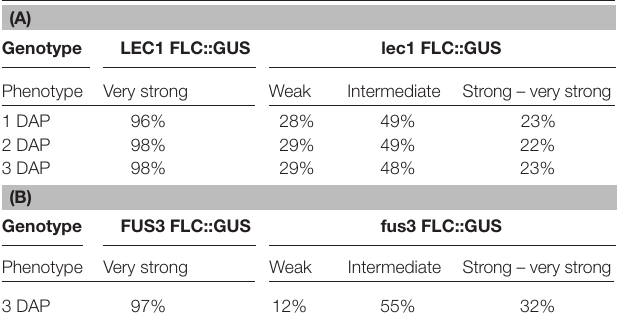
TABLE 1 | GUS expression during embryo development is determined by the activity of LEC1 in the zygote (A) or FUS3 activity in the embryo ( B ; adapted from Tao et al., 2017,